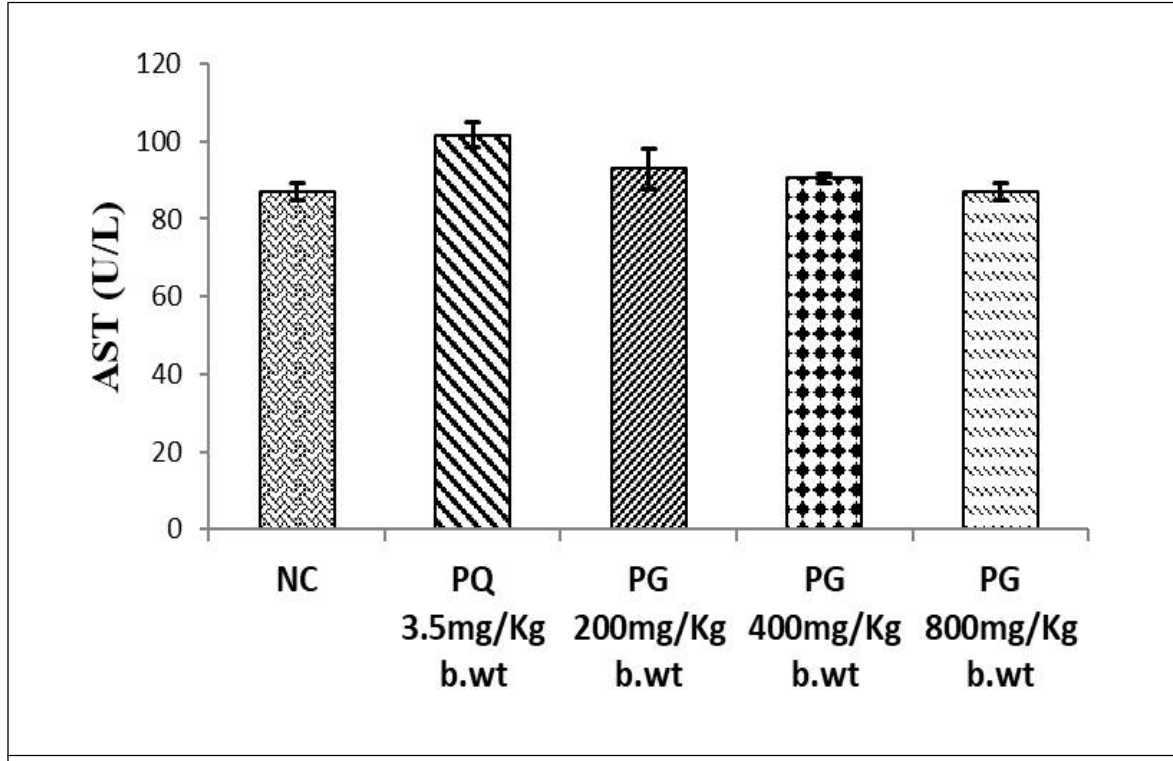
Figure 2: Effect of Psidium guajava leaf extract administration on serum aspartate aminotransferase activities of male Wistar albino rats exposed to 3.5 mg/kg b.wt Paraquat